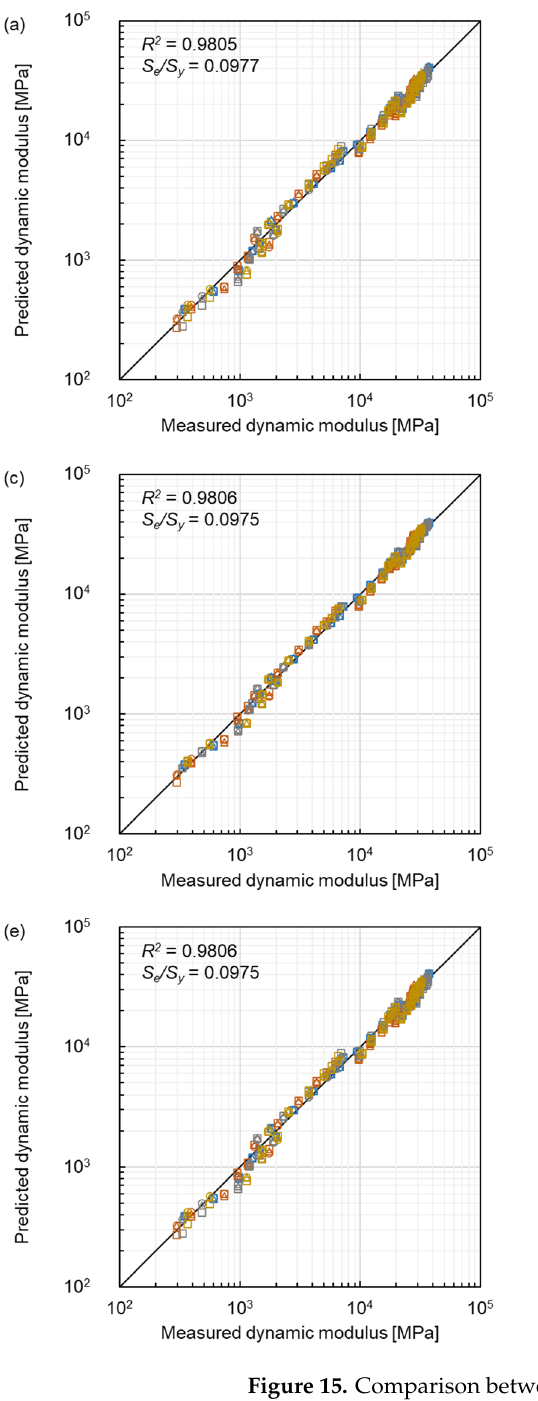
Figure 15. Comparison between measured dynamic modulus and predicted dynamic modulus of five shift factor equations: ( a ) log-linear equation, ( b ) quadratic polynomial equation, ( c ) Arrhenius equation, ( d ) WLF equation and ( e ) Kaelble equation.